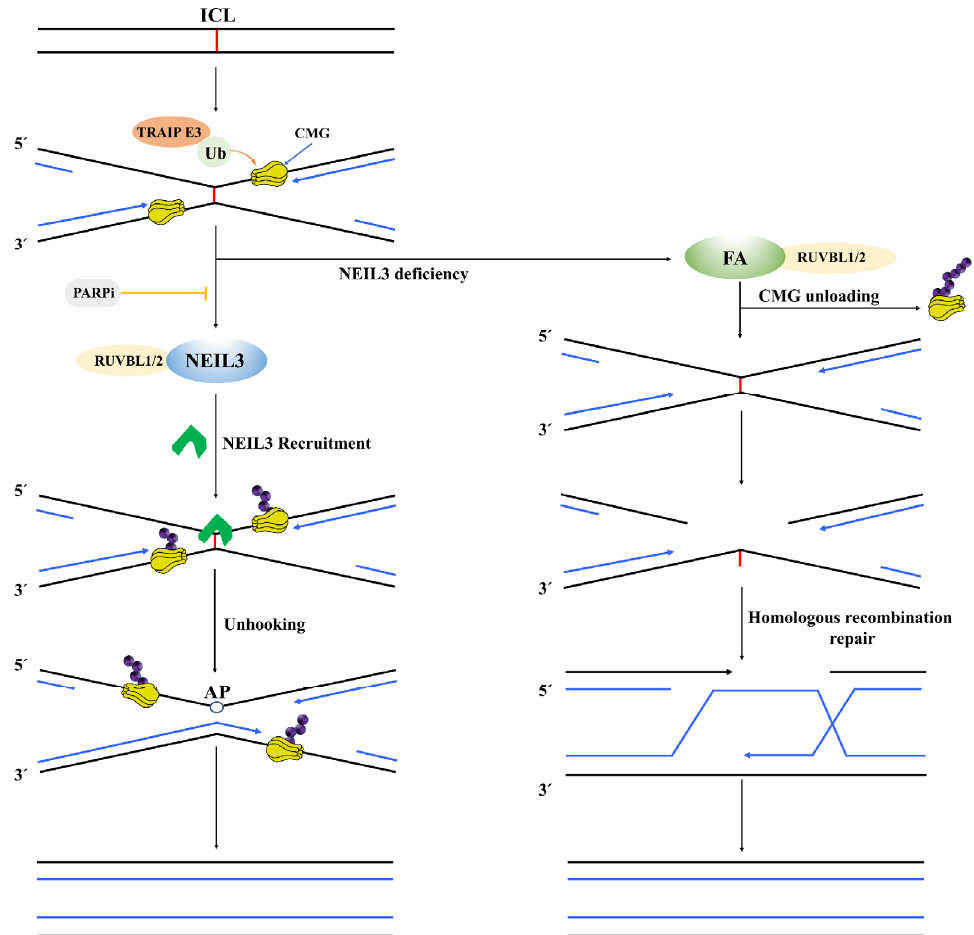
Figure 2. A schematic diagram of the NEIL3 pathway and FA pathway synergistically repairing ICL. First, the E3 ubiquitin ligase TRAINP ubiquitinates the CMG helicase; the short CMG ubiquitin chain can directly bind and recruit NEIL3. NEIL3 specifically cleaves two N-glycosyl bonds in ICLs, allowing ICLs to unhook without generating DSBs. When NEIL3 is deficient, the long CMG ubiquitin chain activates the FA pathway by unloading CMG; however, this process generates DSB, and then the HR pathway is required for further repair of DSB.